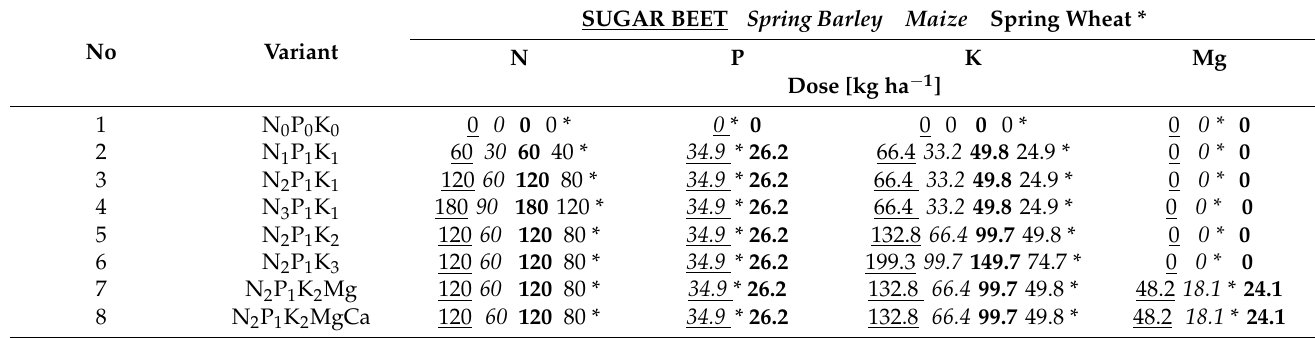
Table 1. Mineral fertilization